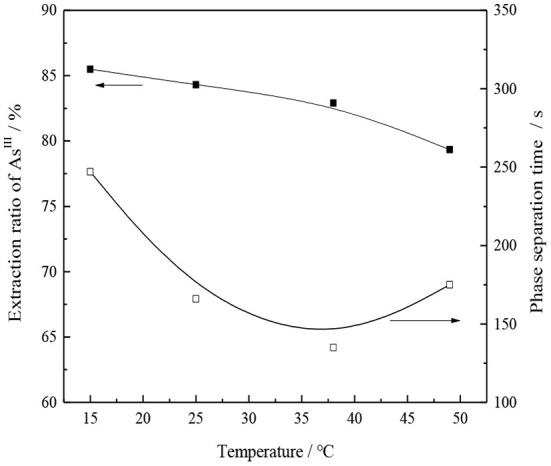
Effect of temperature on AsIII extraction and phase separation.